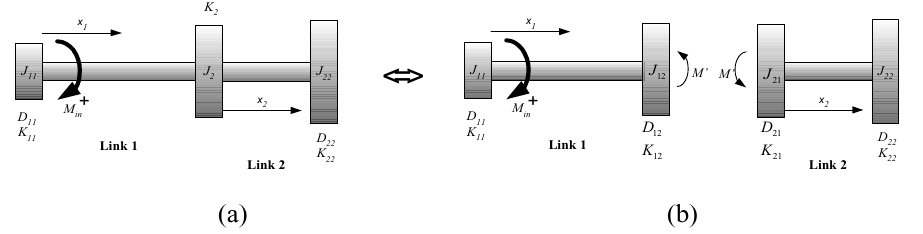
Fig. 6. (a) – A link with inertia in the middle, (b) – An equivalent system.